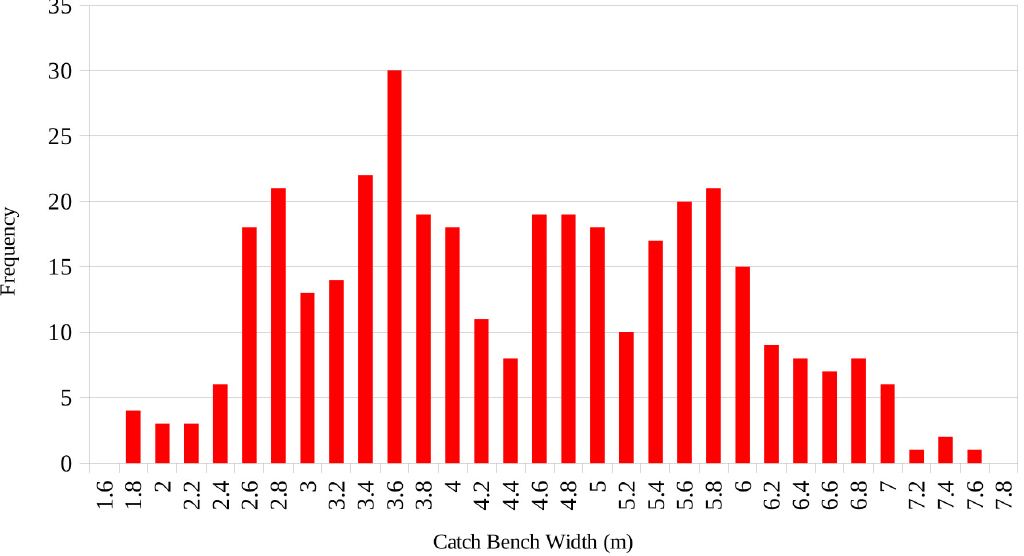
Figure 12. Catch bench analysis at Mine A. The designed catch bench width is 10 m. A total of 371 sections were used for estimating catch bench width at the surveyed